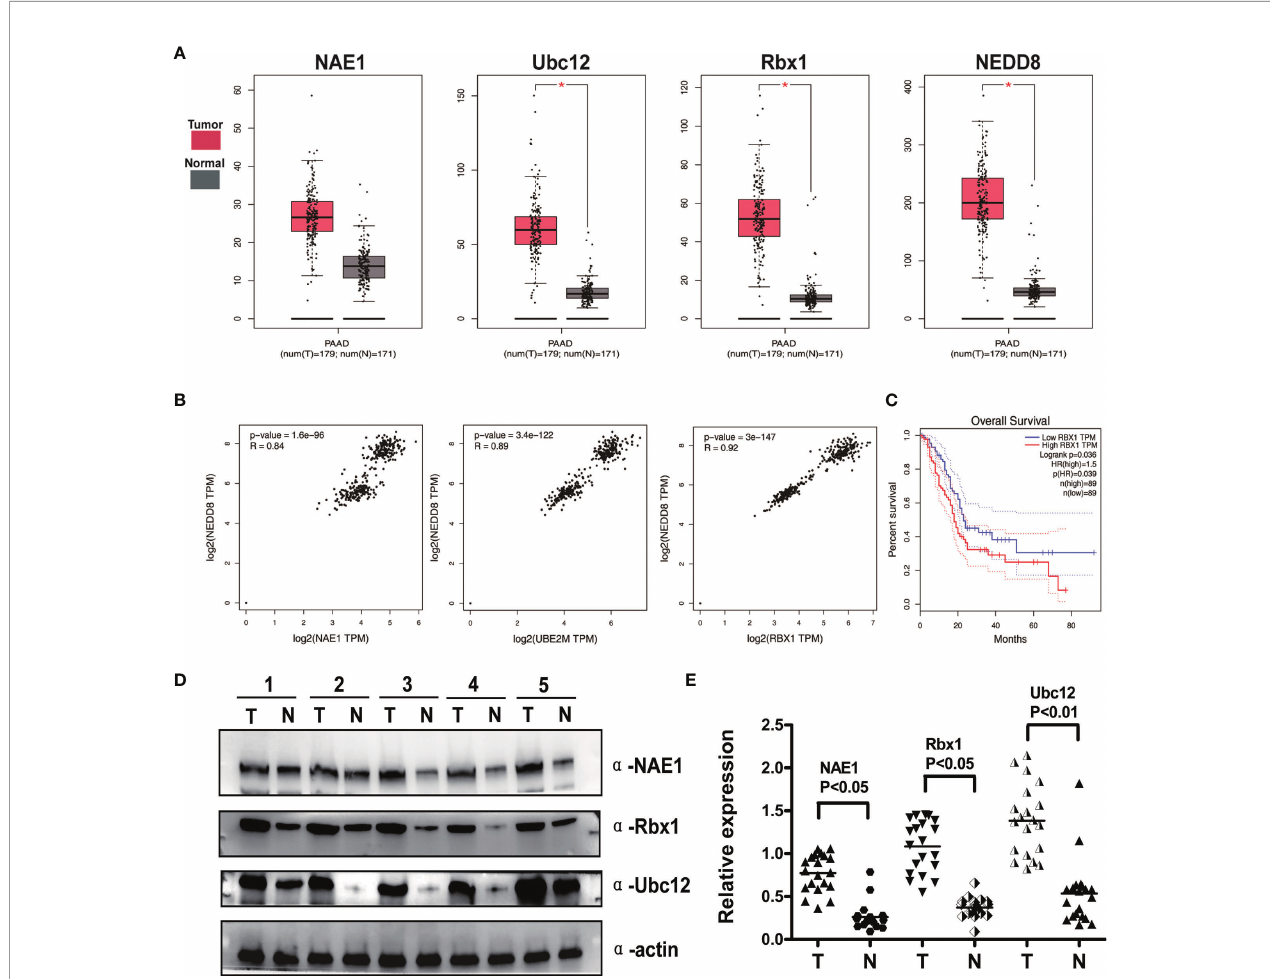
FIGURE 1 | Neddylation pathway overexpression correlates with global NEDD8 levels and predicts poor survival in pancreatic cancer. (A) Bioinformatics analysis of The Cancer Genome Atlas (TCGA) RNA-Seq database in Gene Expression Pro fi ling Interactive Analysis (GEPIA). Gene expression levels of NAE1, Ubc12, Rbx1 and NEDD8 were higher in pancreatic cancer tissues (n = 179) than adjacent normal tissues (n = 171), *p < 0.05. (B) Correlation between neddylation enzymes and global protein neddylation was analyzed in pancreatic cancer (Pearson ’ s chi-square test, TCGA data). (C) High expression of Rbx1 indicated a poor prognosis. Kaplan – Meier curves for overall survival rate of patients with pancreatic cancer according to the mRNA expression of Rbx1 with median gene expression level as the cutoff value (p < 0.05, log-rank test). (D) Immunoblotting (IB) analysis to determine the expression of NAE1, Rbx1, and Ubc12 in pancreatic adenocarcinomas tissues and adjacent normal tissues. Representative results of 5 out of 20 pairs of tissues are shown. T, tumor tissues; N, adjacent pancreatic tissues. (E) Quanti fi cation of protein expression in pancreatic tumor tissues compared with adjacent lung tissues (n =